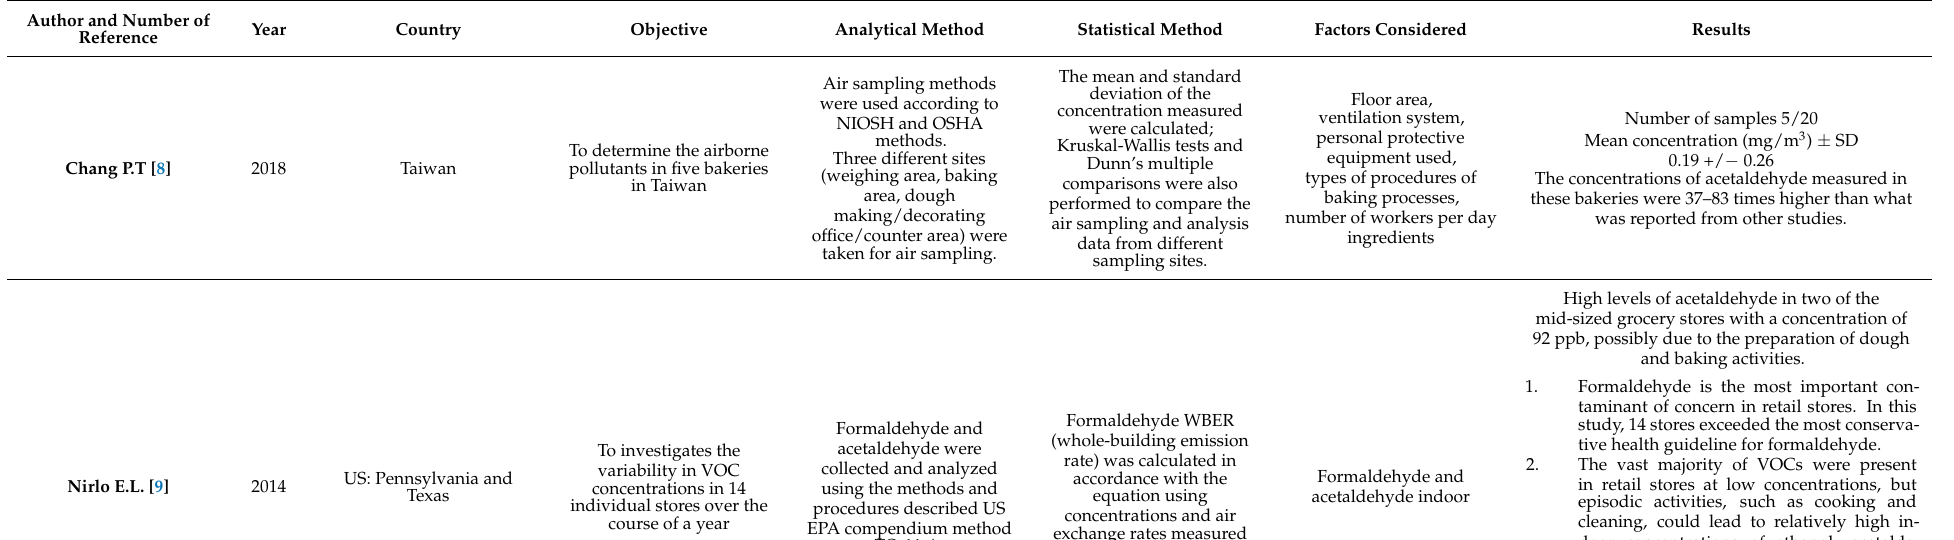
Table 1. Description of studies in which aldehydes assessment was performed in baking